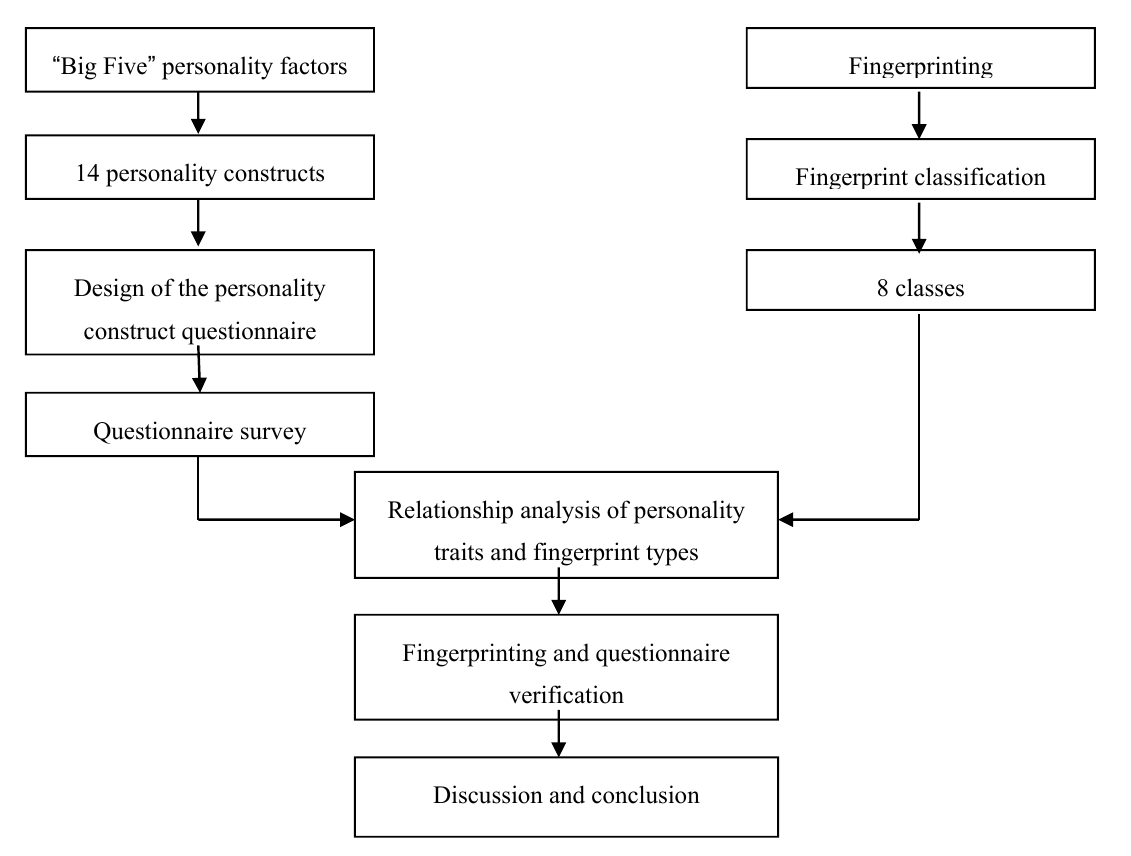
Figure 1. Research framework and flowchart.